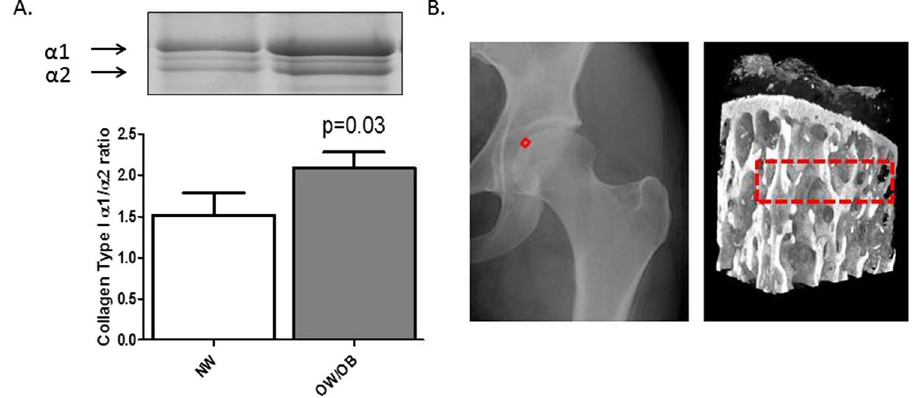
Figure 1. Comparison of the structural composition of femoral head subchondral bone in patients of different BMI cohorts. ( A ) The quantification of the α 1/ α 2 Type I collagen ratio in femoral head subchondral bone. NW = normal-weight (n = 7), OW/OB = overweight/obese (n = 13). Bars represent mean α 1/ α 2 values ± SEM as determined through ImageJ. The gel image is a representative coomassie-stained SDS PAGE gel of a NW OA and OW/OB OA femoral head, demonstrating the separation of α 1/ α 2 type I collagen isoforms. ( B ) Representation of the area from the trabecular bone for micro-CT analysis. The area analysed was a 1 cm 3 from the most medial aspect of the femoral head (as indicated by the red square on the femoral head). Dashed line box = region of interest which was reconstructed for bone parameter